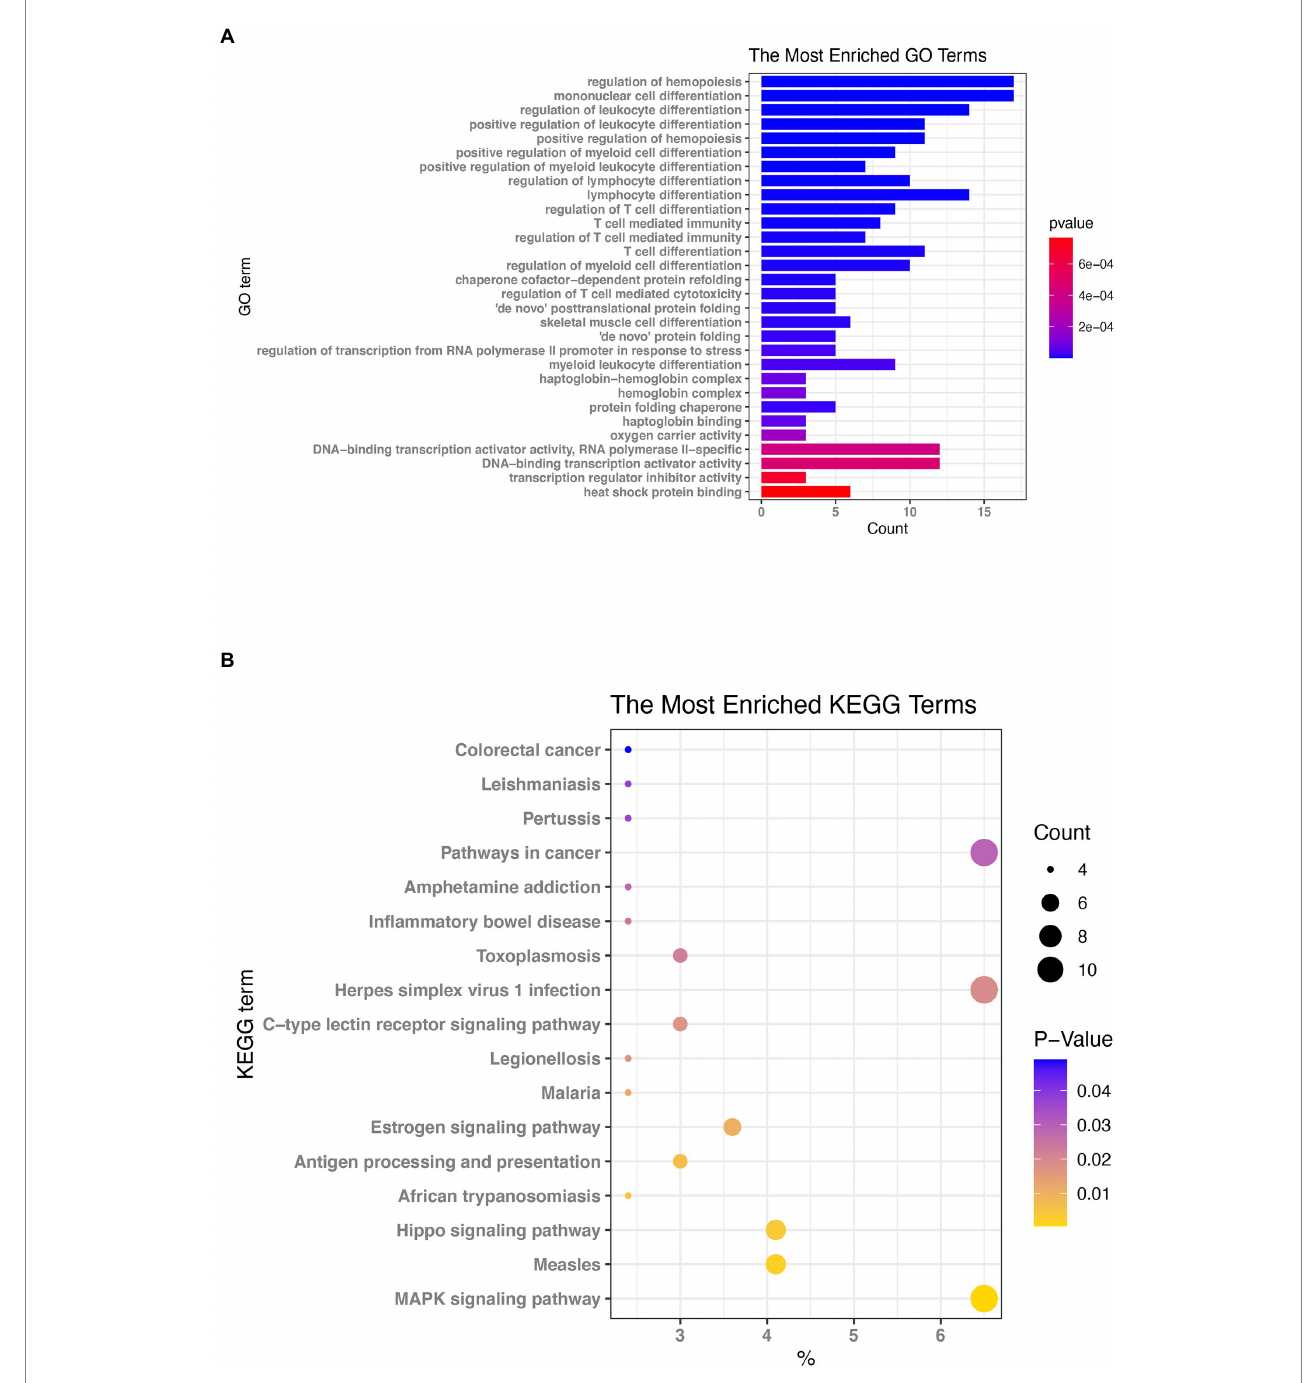
FIGURE 4 Enrichment evaluation (A) GO enrichment: the graph depicts the ranking of the most enriched pathways, with the number of genes enriched in each GO annotation represented by the horizontal bar and the size of Log 10 ( p . value) reflected by the bar’s color. (B) Enrichment of Kyoto Encyclopedia of Genes and Genomes (KEGG) signaling pathways: The size of the bubbles in the graph represents the number of genes enriched in each signaling route, while the color of the spots indicates their significance